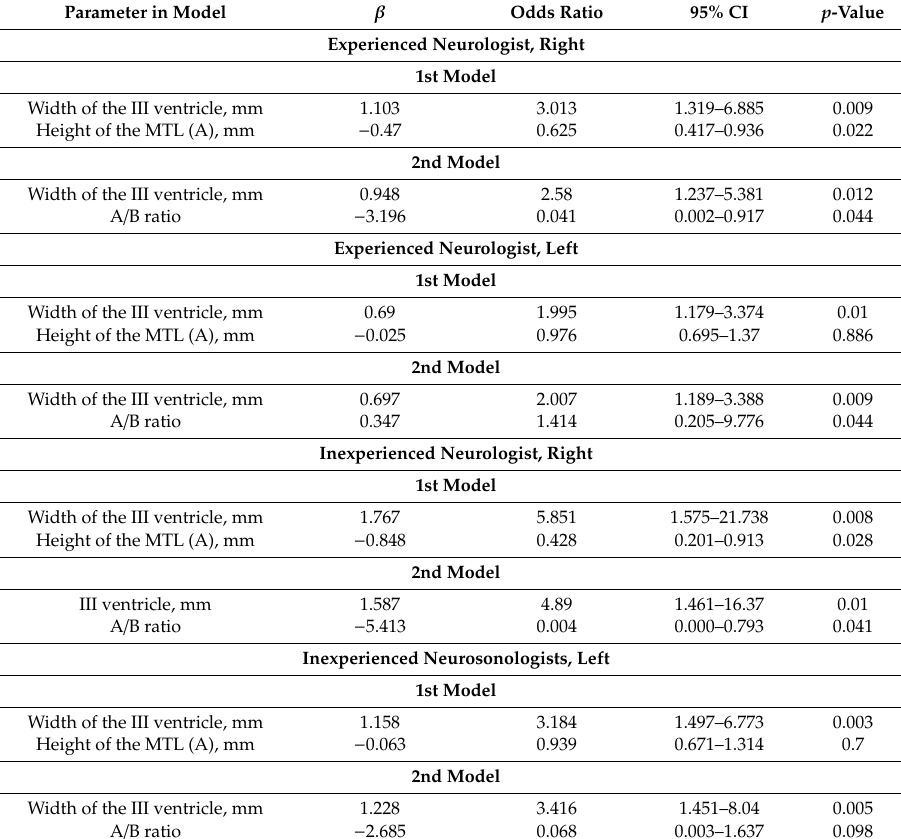
Table 3. The predictive power of the medial temporal lobe height (A) and of the medial temporal lobe height to choroidal fissure height ratio (A / B) as measured by transcranial sonography for the likelihood that the subject has Alzheimer’s disease. Results of logistic regression analyses. Parameter in Model β Odds Ratio 95% CI p